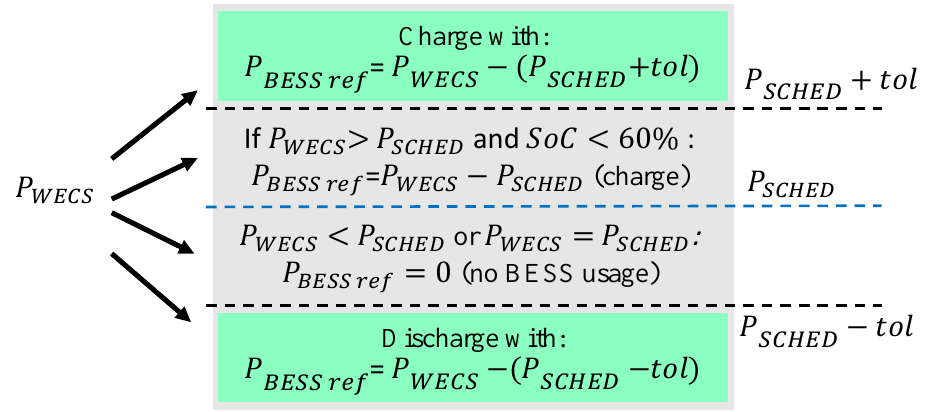
Figure 20. Simple rule-based management